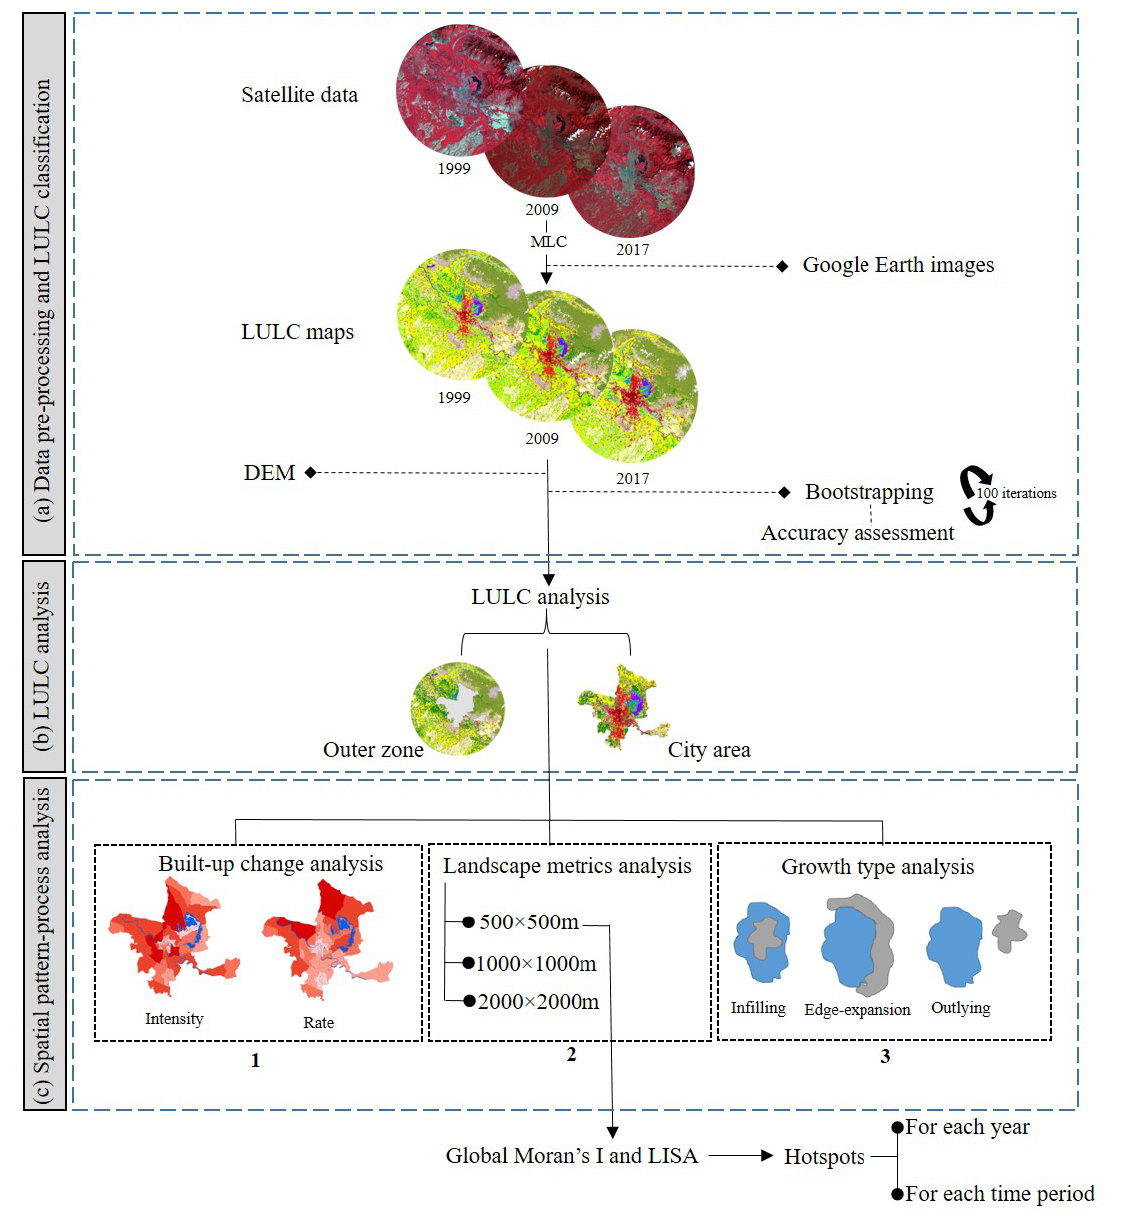
Figure 2. Methodological framework showing the major steps involved in the study: ( a ) data pre-processing and land-use and land-cover (LULC) classification, ( b ) LULC analysis, and ( c ) spatial pattern-process